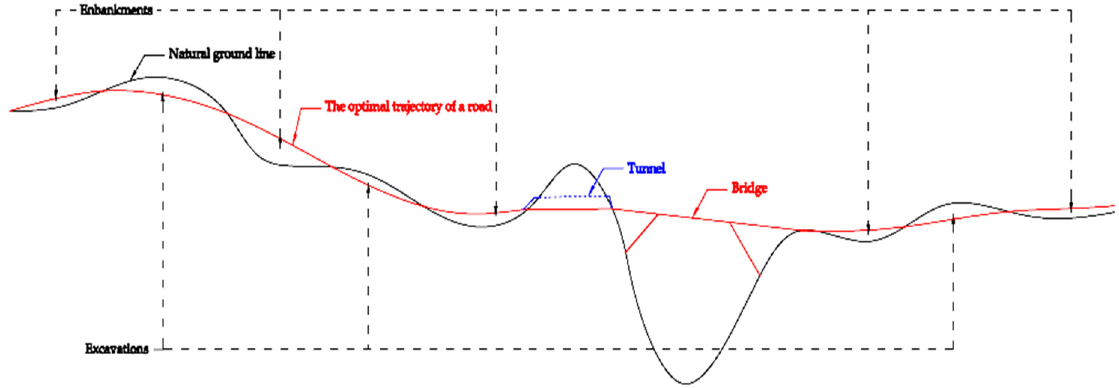
Figure 14. The optimal trajectory of a road depending on the elevation of the natural land. When designing a new road or railway, a number of initial design factors must be taken into account, such as: road category, design speed, width of a traffic lane, number of lanes, traffic frequency, equipment size, etc. Depending on the route imposed on the road, there are also other specific aspects that must be taken into account: